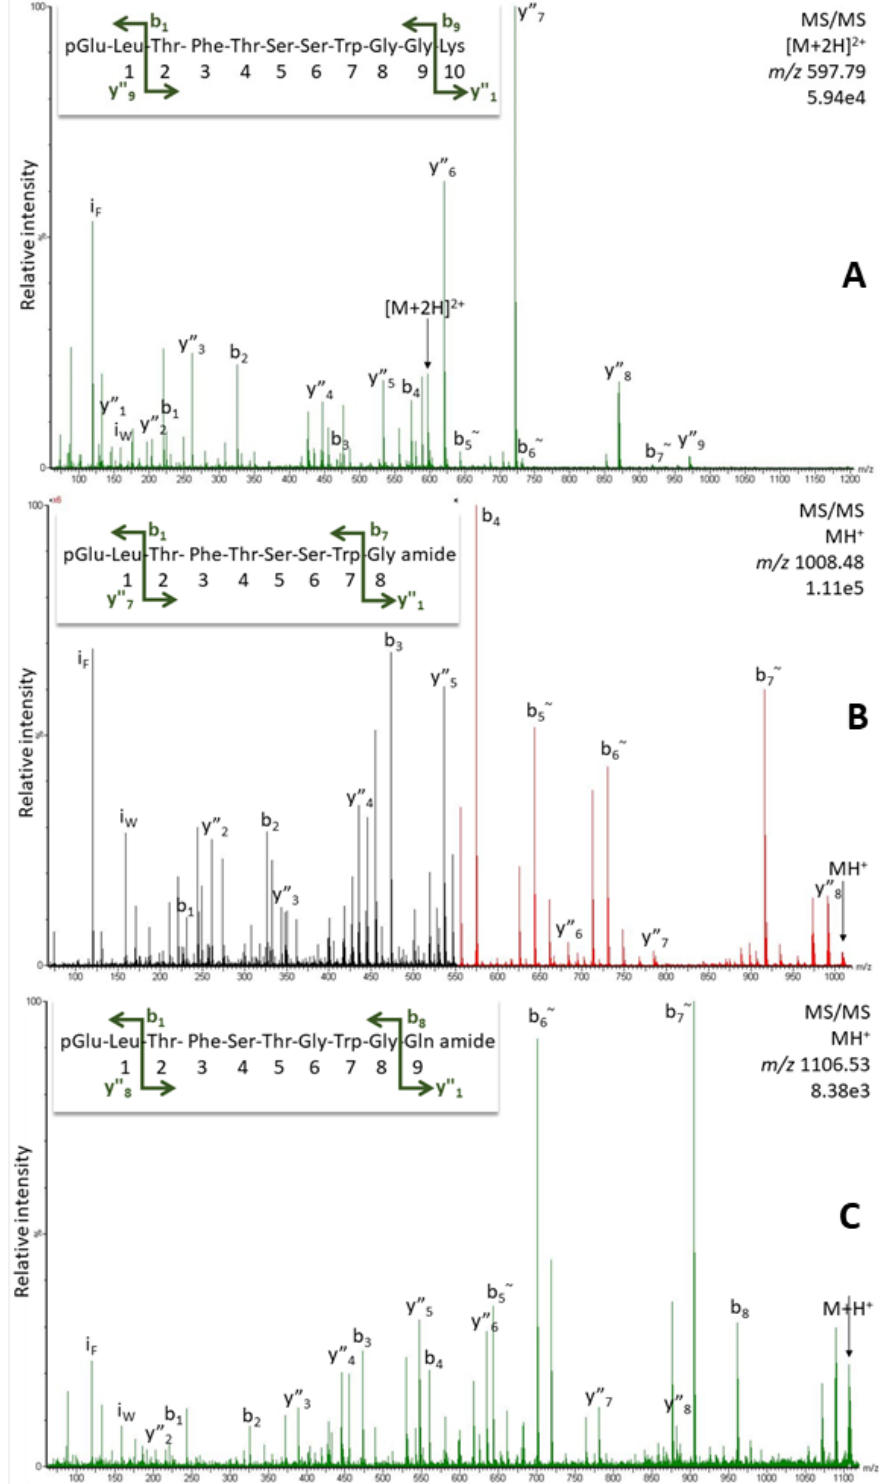
Figure 7. MS/MS spectra for peptides in O. nubilalis assigned to ( A ) Vanca-AKH, ( B ) Manse-AKH, and ( C ) Ostnu-AKH of the doubly- ( A ) and singly-charged peptide ions ( B , C ): 1 µ L injection, equivalent to the glandular content of 1.25 CC. Peaks were labeled according to the b- and y-ion series as calculated in the original spectra in Supplementary Figures S12, S13 and S15. For sequence validation, see Supplementary Figures S14 and